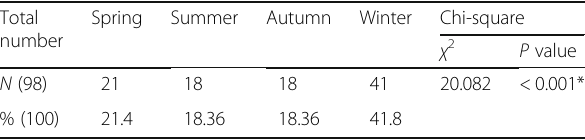
Table 2 Circannual variation of stroke onset